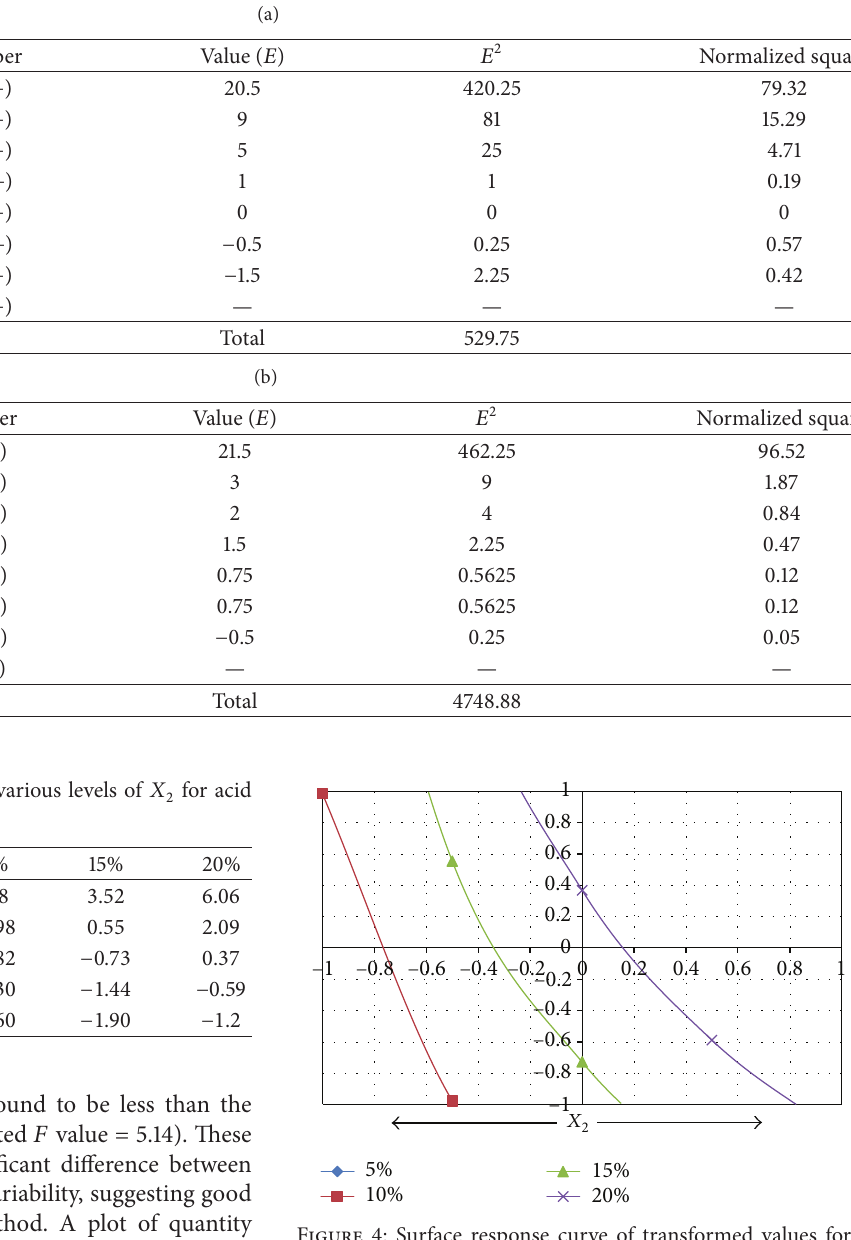
Figure 4: Surface response curve of transformed values for acid degradation from − 1 to +1